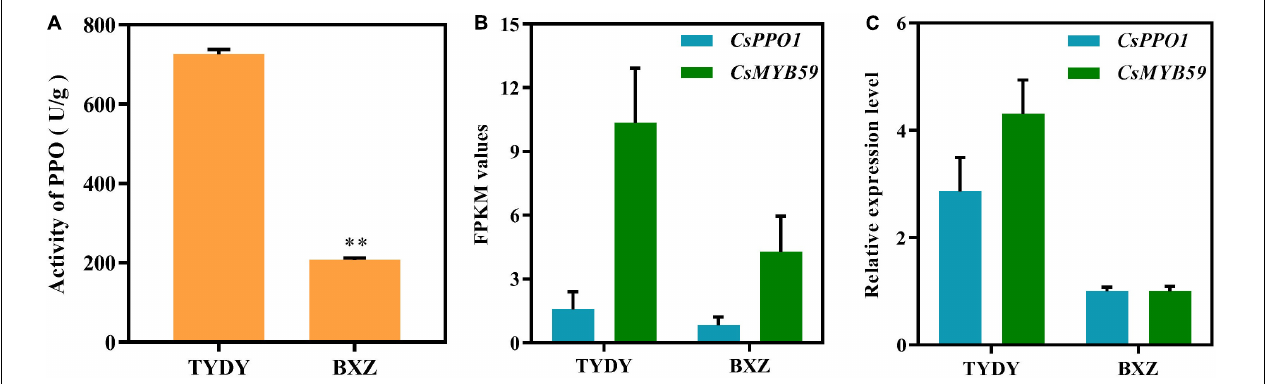
FIGURE 1 | Polyphenol oxidase activity and gene expression of CsPPO1 and CsMYB59 in different tea cultivar leaves. (A) PPO activity in TYDY and BXZ. (B) The FPKM values of CsPPO1 and CsMYB59 in TYDY and BXZ. (C) The relative expression level of CsPPO1 and CsMYB59 in TYDY and BXZ. PPO, polyphenol oxidase; TYDY, Taoyuandaye; BXZ, Bixiangzao; FPKM, fragments per kilobase of transcript per million mapped reads. **represents significant difference at P <